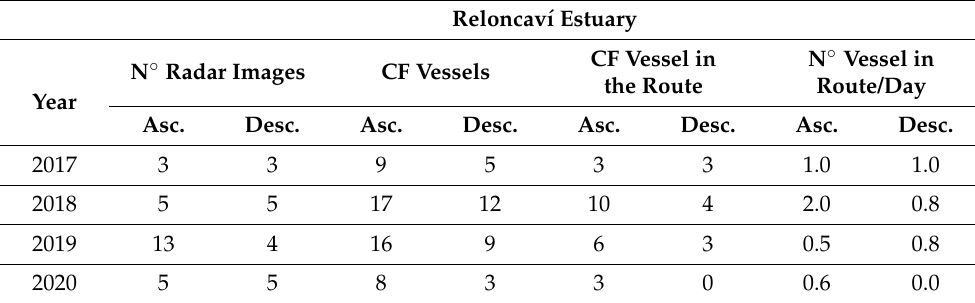
Table 2. Summary of the vessel detection analysis using the object-oriented algorithm and SAR Sentinel-1 data for the Reloncavi Estuary (ascending, Asc.; descending, Desc.). CF: Cumulative frequency.